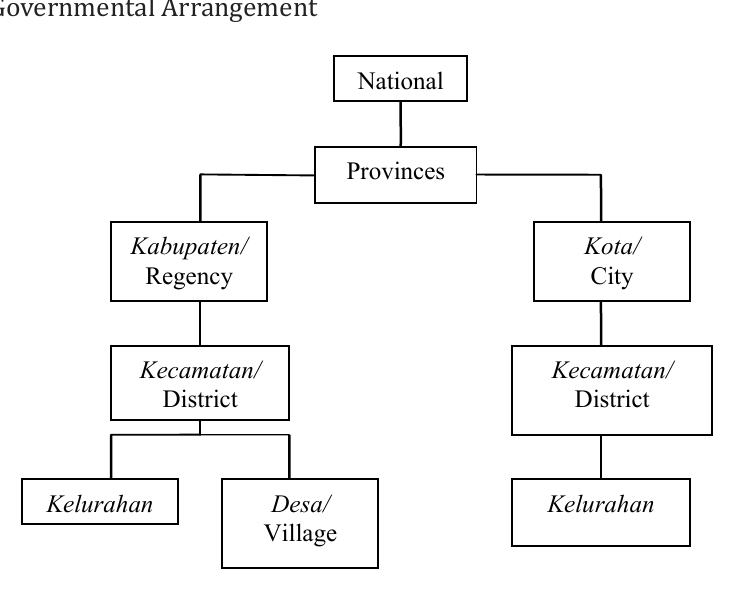
Figure 1. The administrative arrangement in Indonesia